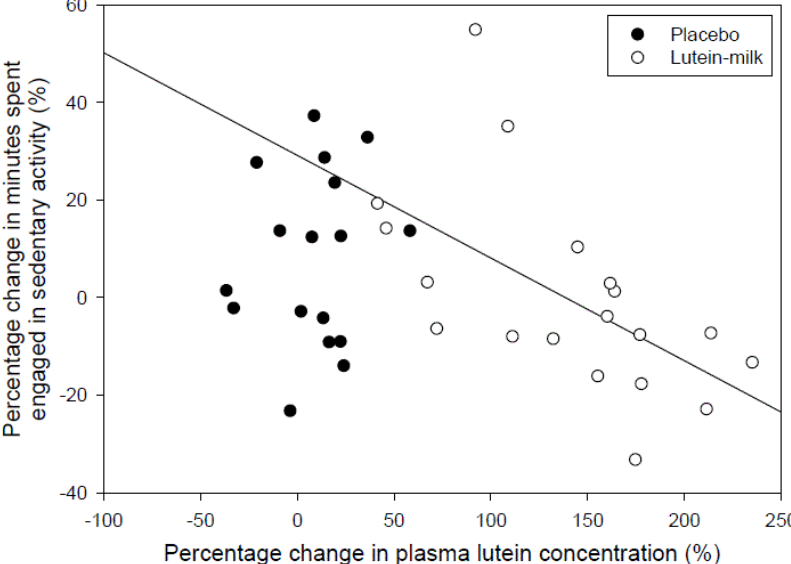
Figure 4. Relationship between percentage change in plasma lutein concentration and percentage change in minutes spent engaged in sedentary activity determined using